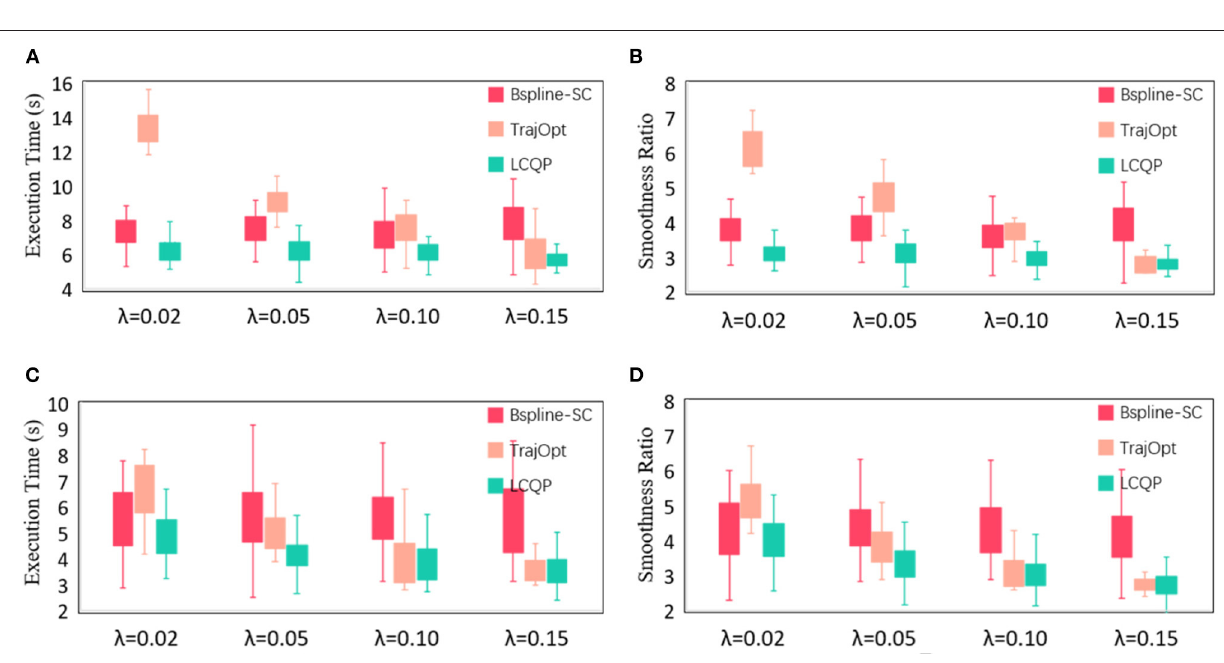
trajectory from any state, which is essentially a motion planning method. But it also can be used as a post-process algorithm. The results of the three optimization methods are represented by box-plots of Execution time T E and Smoothness ratio R in Figure 7 . For some items with